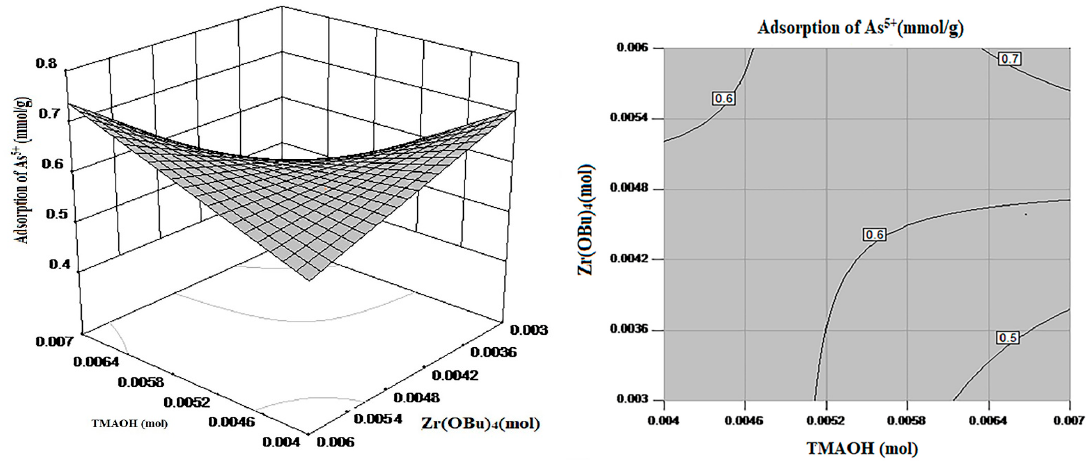
Figure 3. Response surface and contour of As 5+ removal under the interaction of Factor 2 and 3.